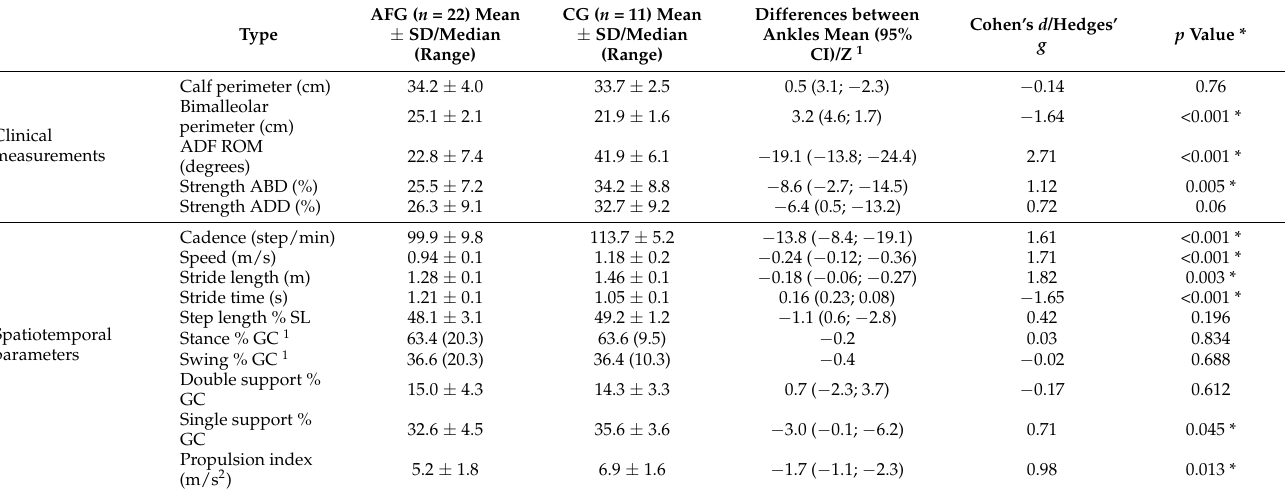
Table 3. Difference between bimalleolar ankle fracture patients and the control group in clinical measurements and spatiotemporal gait